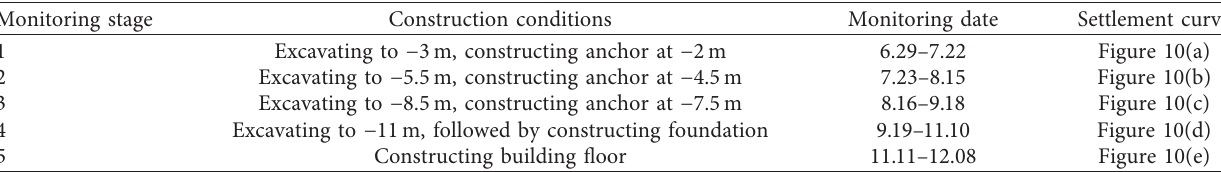
Table 2: Division of monitoring